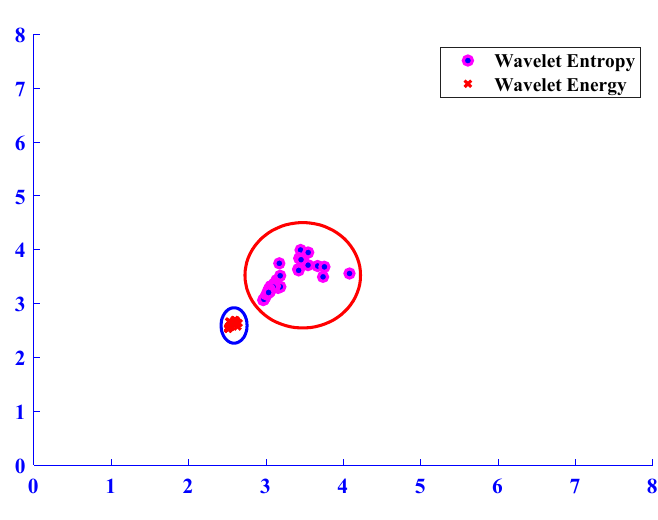
Figure 9. Wavelet features distribution.